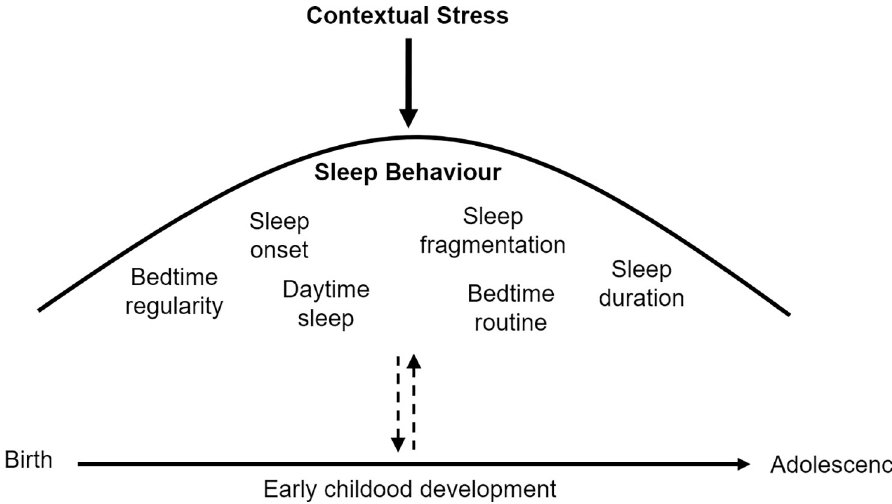
Fig 1. Working model. Sleep behavior is an umbrella protecting developmental outcomes from influences of contextual stress [64–66].